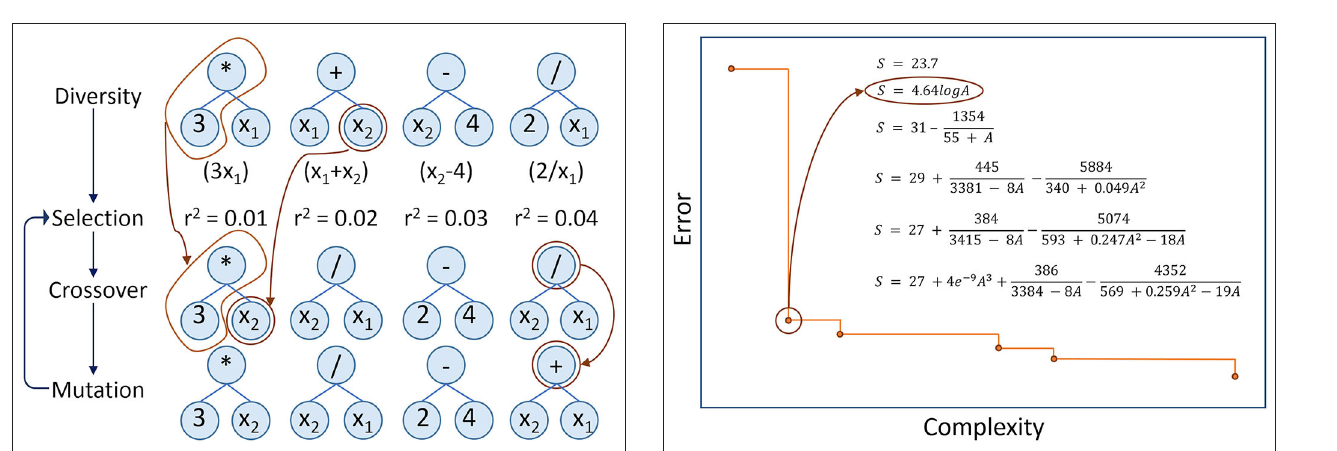
FIGURE 1 | Schematic representation of the symbolic regression workflow. The basic representation is a parse-tree where building blocks such as variables (in this case: x 1 , x 2 ), parameters (integers or real numbers), and operators (e.g., + , –, × , ÷ ) are connected forming functions (in parenthesis under the first line of trees). Initial equations are generated by randomly linking different building blocks. Equations are combined through crossover, giving rise to new equations with characteristics from both parents (arrows linking the first and second rows of trees). Equations with better fitness (e.g., R 2 ) have higher probabilities of recombining. To avoid loss of variability, a mutation step is added after crossover (arrows linking the second and third rows of trees). After multiple generations, evolution stops and a set of free-form equations best reflecting the input data is found.